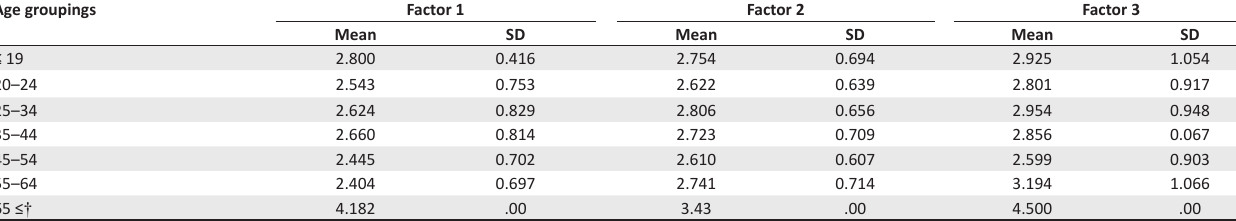
TABLE 14: Descriptive statistics for age groupings.